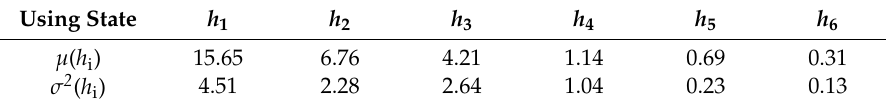
Table 2. The mean and variance of duration probability of each macro state.